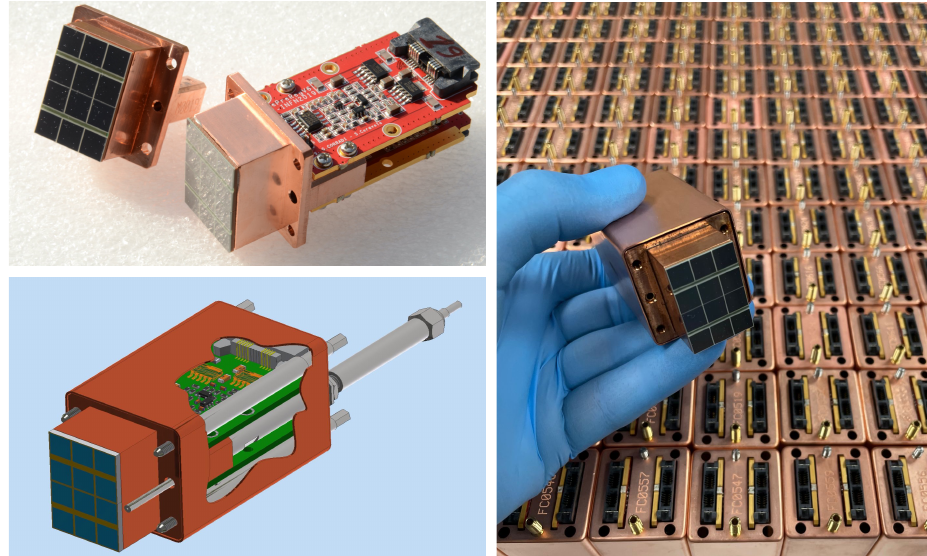
Figure 2. Bottom-left : rendering of an ROU, fibre-optic needle holder and Faraday cage are shown. Top-left : SiPM holder and FEE assembly. Right : ROUs from production